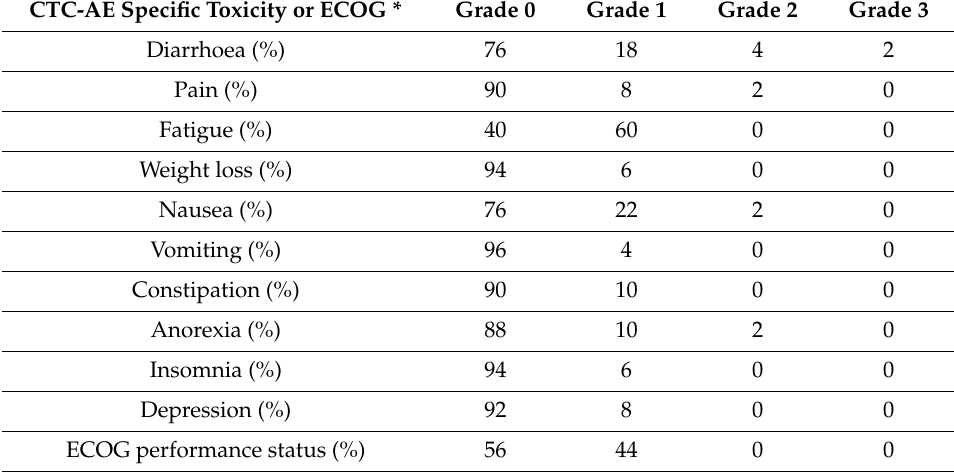
Table 2. Adverse events as graded by Common Toxicity Criteria (CTC-AE) and Eastern Cooperative Oncology Group (ECOG) performance status at week three of chemoradiation, n =